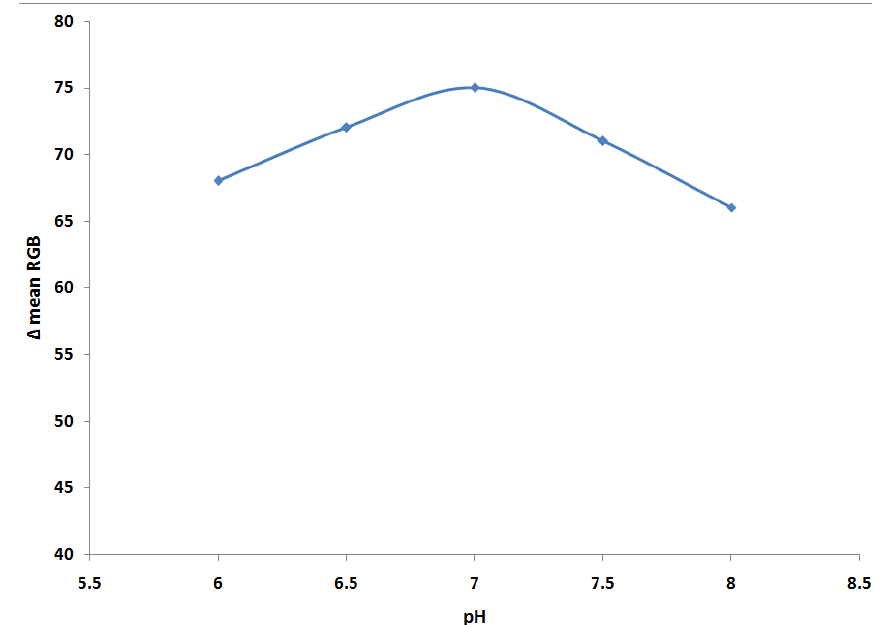
Figure 4. The effect of pH buffer on the AOX/PANI biosensor sensor toward ethanol